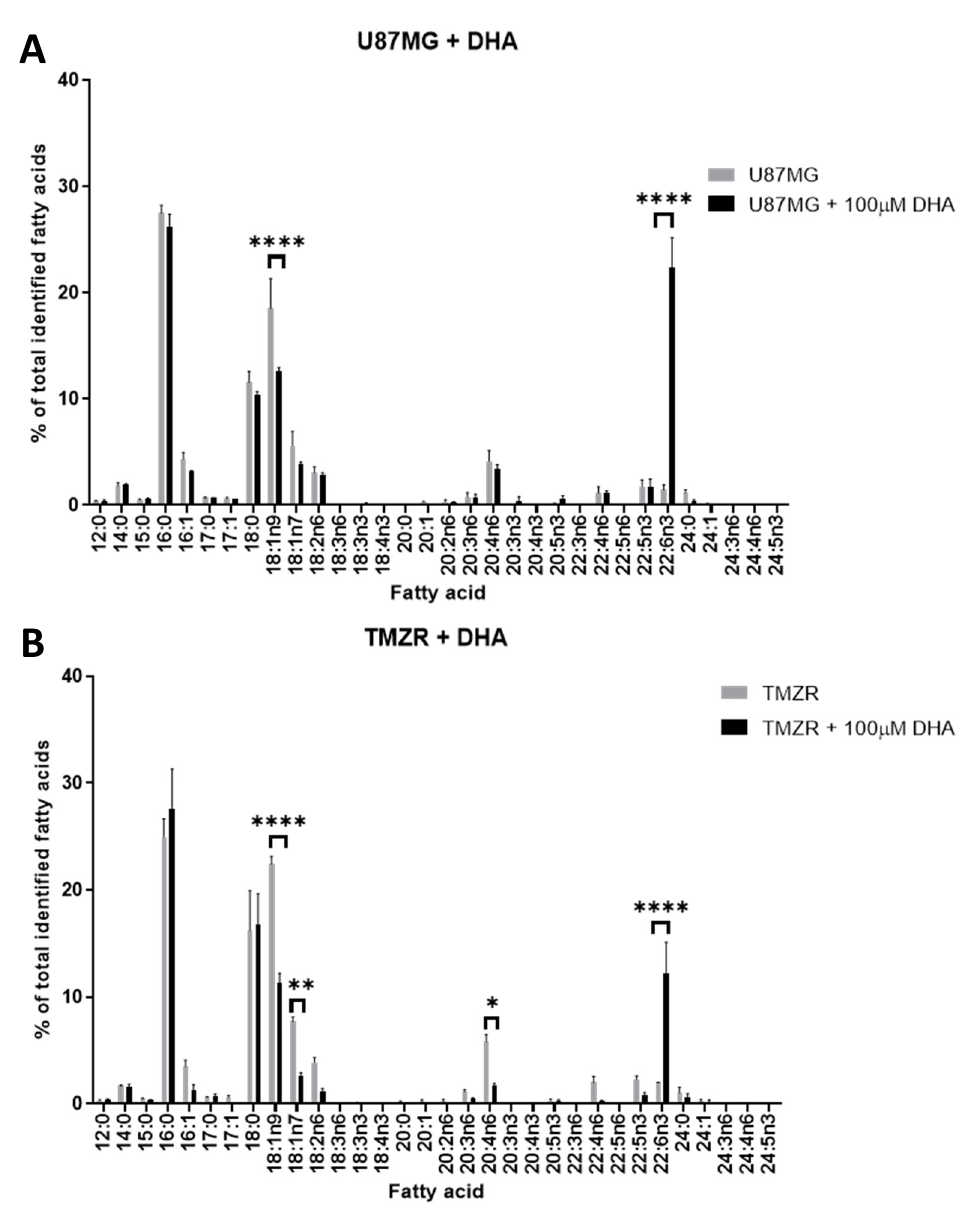
Figure 7. Effects of docosahexaenoic acid (DHA) on fatty acid composition of U87MG and TMZR cells ( A ) U87MG cells ( B ) TMZR cells. Data are presented as mean ± SEM, N = 3. Differences were considered significant at p < 0.05. * = p < 0.05; ** = p < 0.01; ****= p < 0.0001.